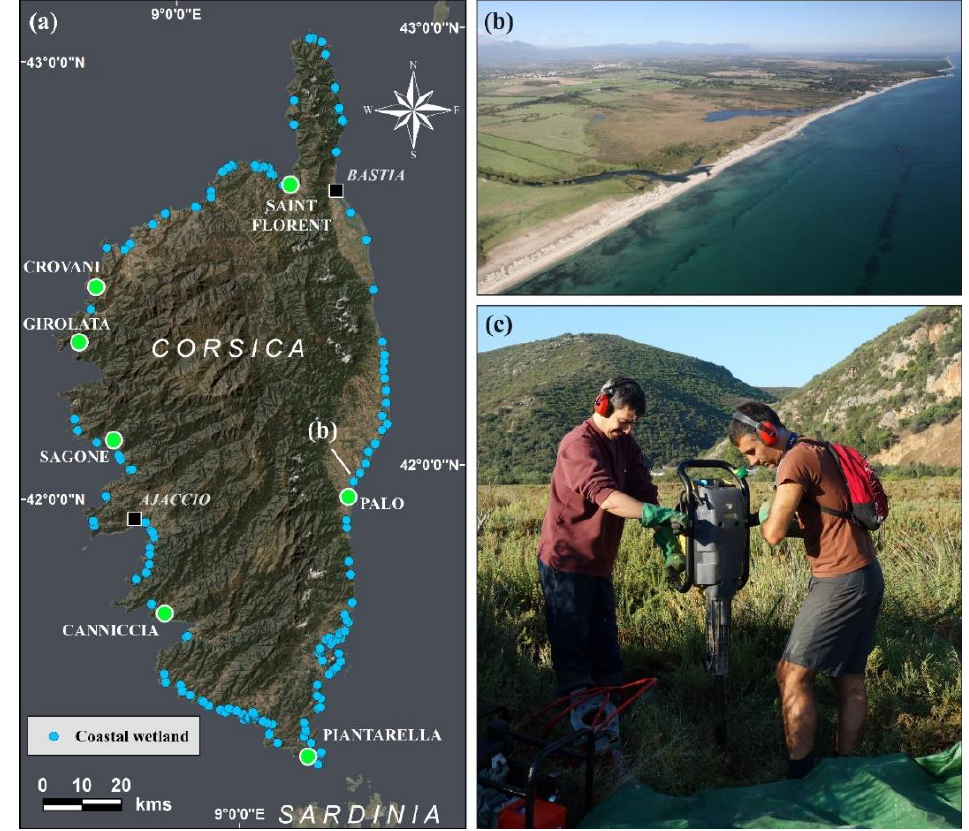
Figure 2. Coastal wetlands of Corsica investigated for palaeovironmental purposes. ( a ) Location map of the coastal wetlands (blue circles), and the study sites for the present paper are marked with a green circle. ( b ) is an oblique view of the Gradugine coastal wetland (eastern Corsica), situated to the north of the Abatesco River mouth. (Credits: M. Luccioni). ( c ) The vibrocoring technique (Credits: M.